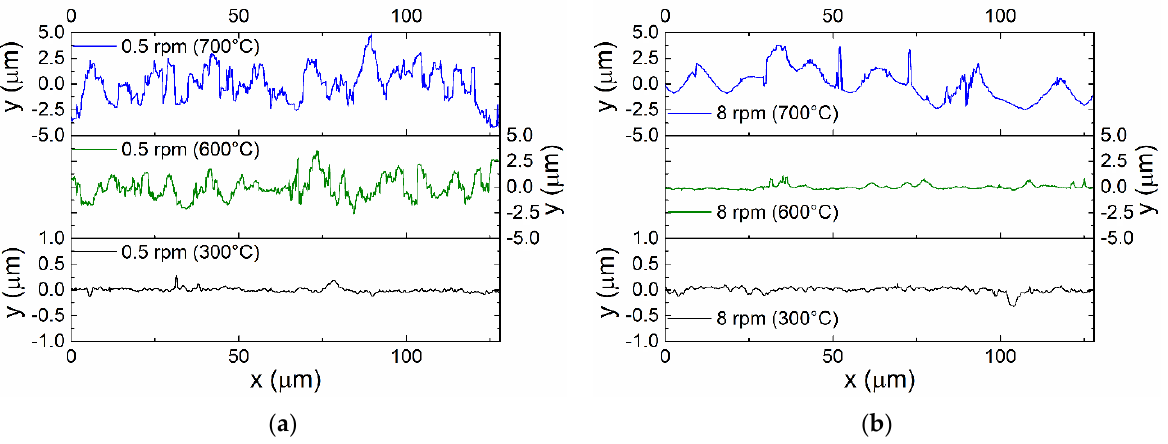
Figure 5. Roughness profiles obtained from oxidized surfaces of multilayer coatings deposited at 0.5 ( a ) and 8 RPM ( b ) rotation rates.